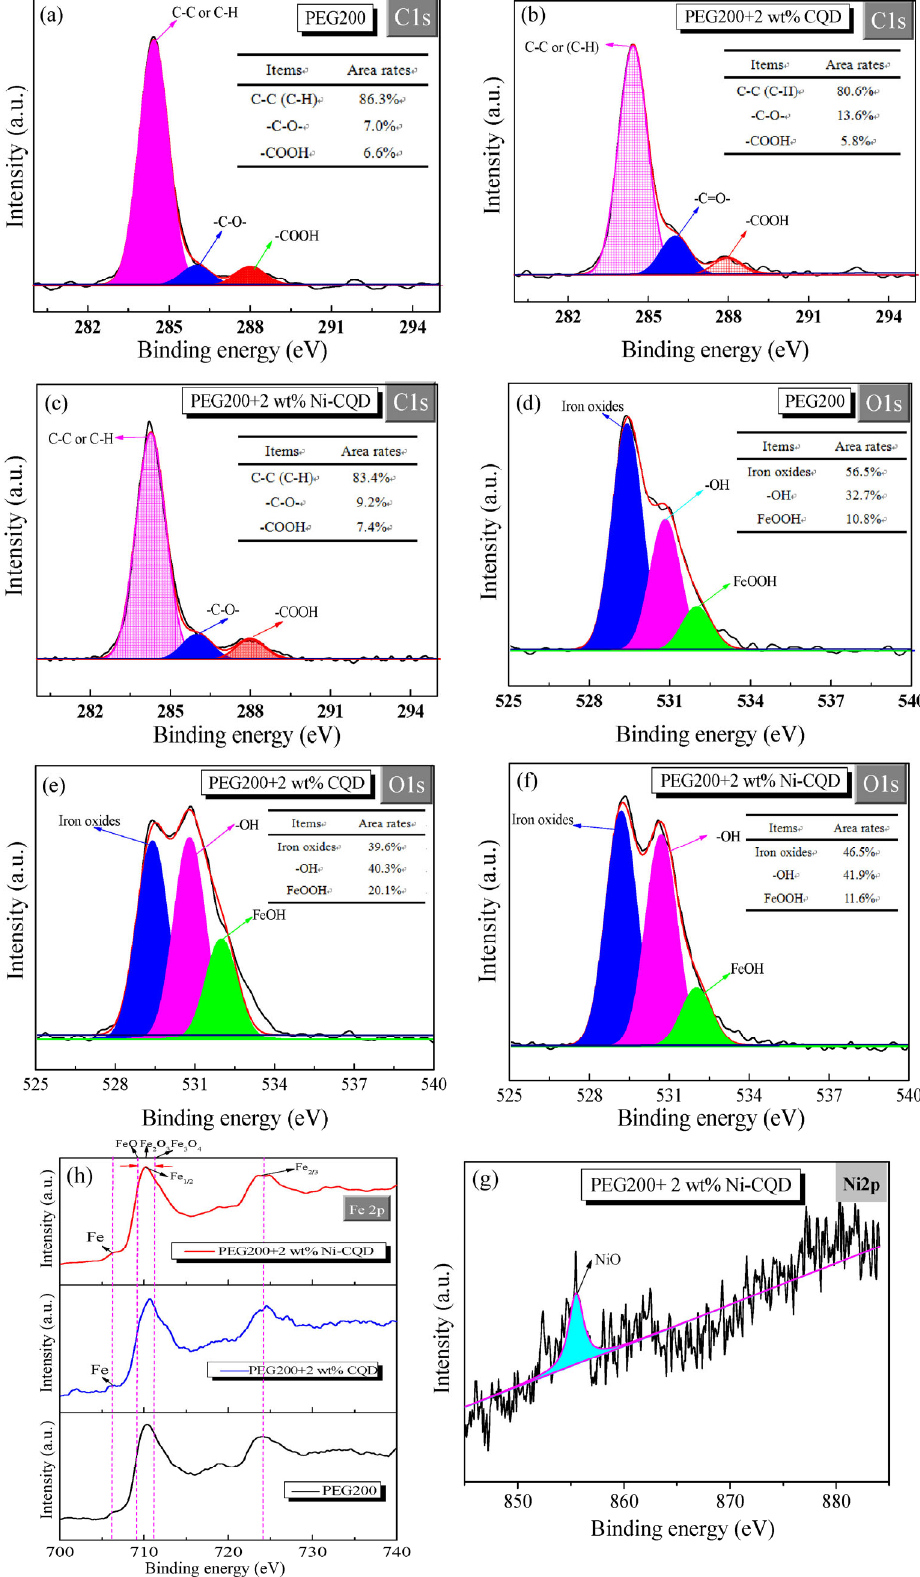
Fig. 12 C1s, O1s, Fe2p and Ni2p spectra of wear zones lubricated with different oil